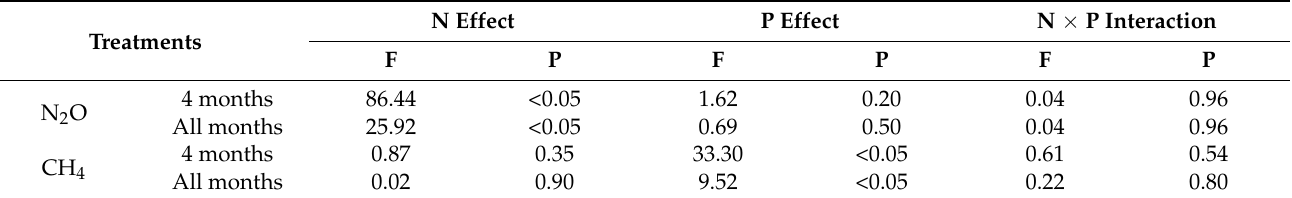
Table 3. Two-way ANOVA for mean N 2 O emissions and CH 4 uptakes over the first 4 months and all months under the N and P treatments in the subtropical Chinese fir plantation. F: mean square ratio, P: p